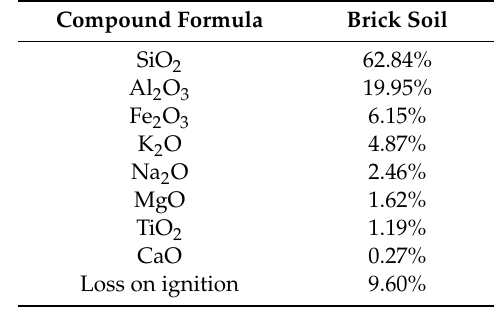
Figure 3. Particle-size distribution curve of brick soil used in this study. Table 1. Soil chemical properties.